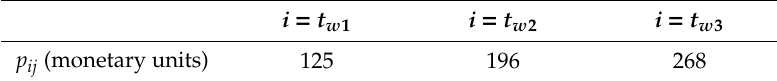
Table A8. Pre-COVID treatment dental charges.